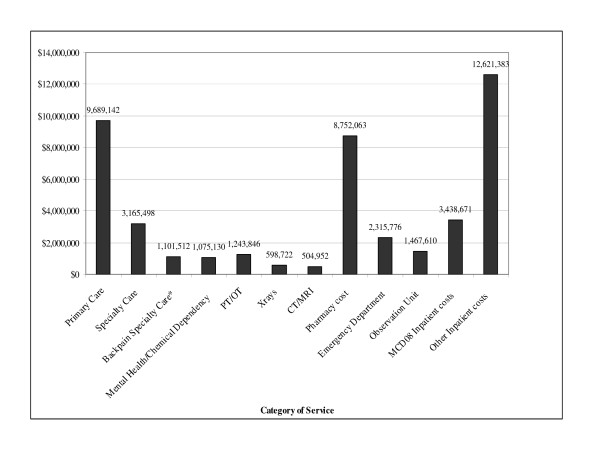
Average annual total costs for $16,567 LBP patients by category of service.